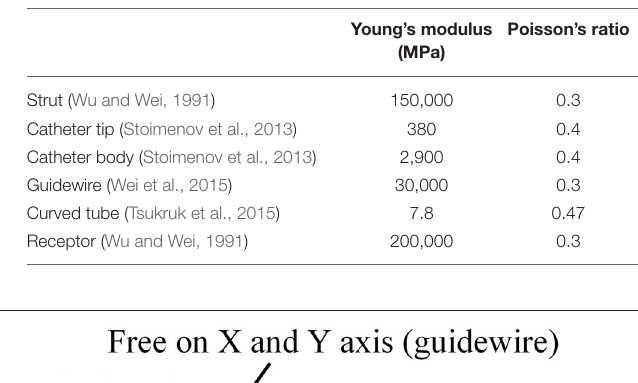
Frontiers in Physiology |